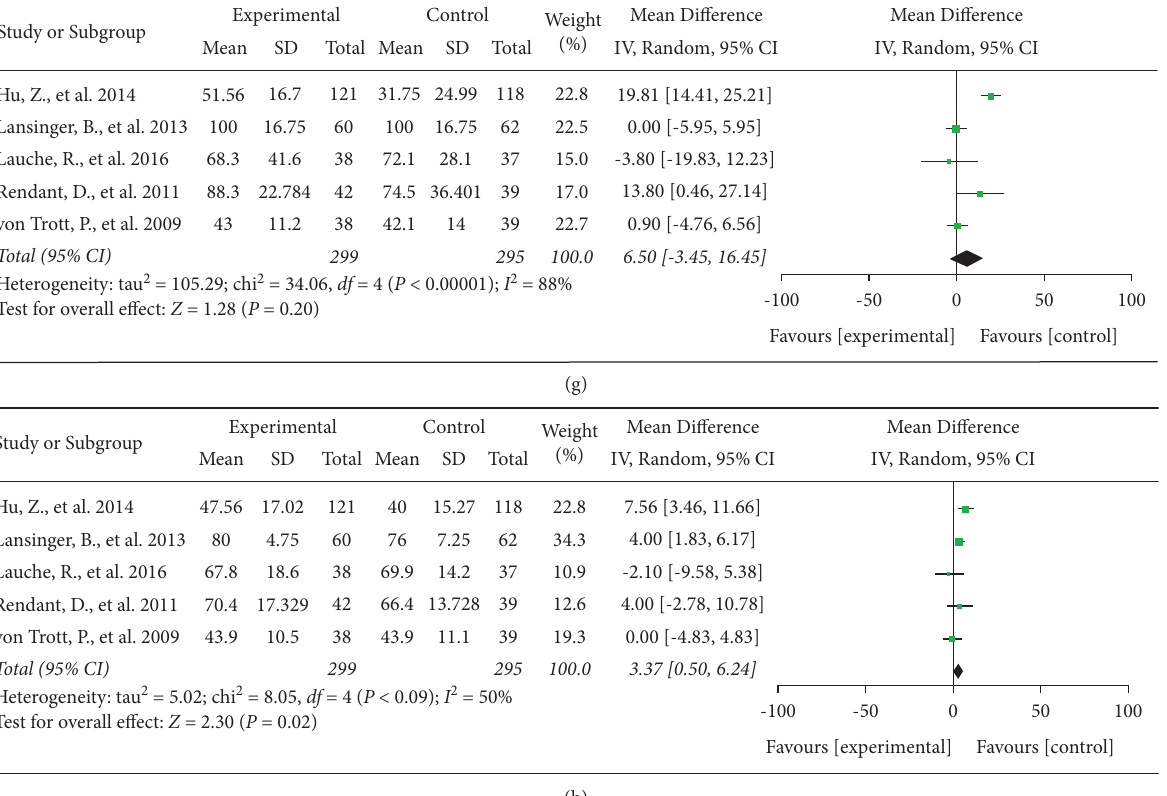
Figure 4: Effects of TCMBE on QOL. TCMBE: traditional Chinese mind and body exercise; QOL: quality of life; SF-36: 36-item short-form health